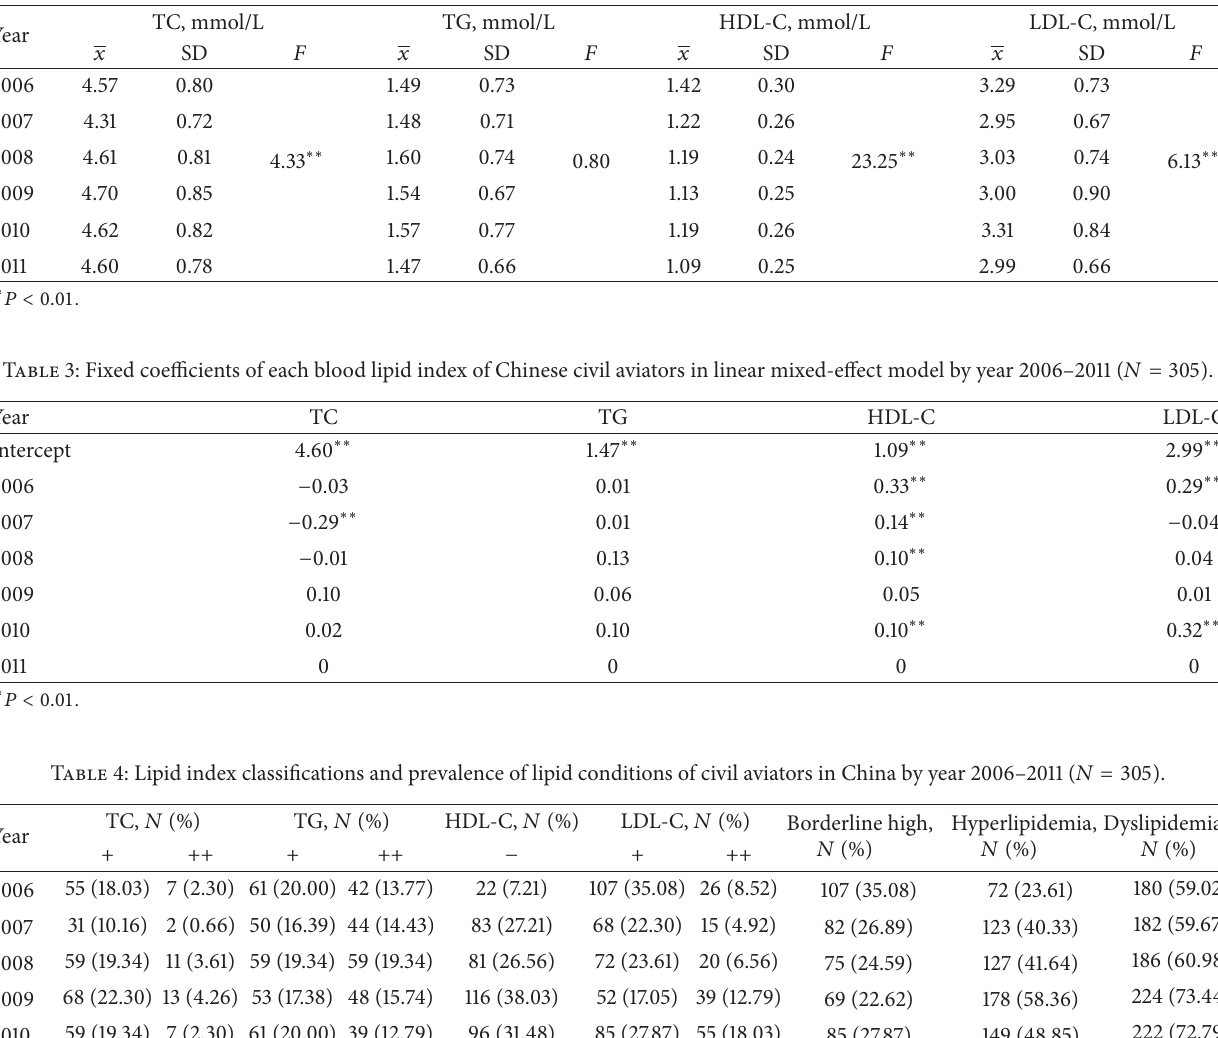
Table 2: Blood lipid data for civil aviators in China by year 2006–2011 ( 𝑁 = 305 ).